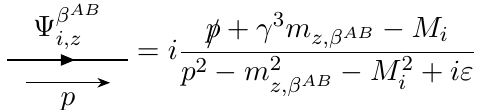
Figure 6. The propagator in the W = 0